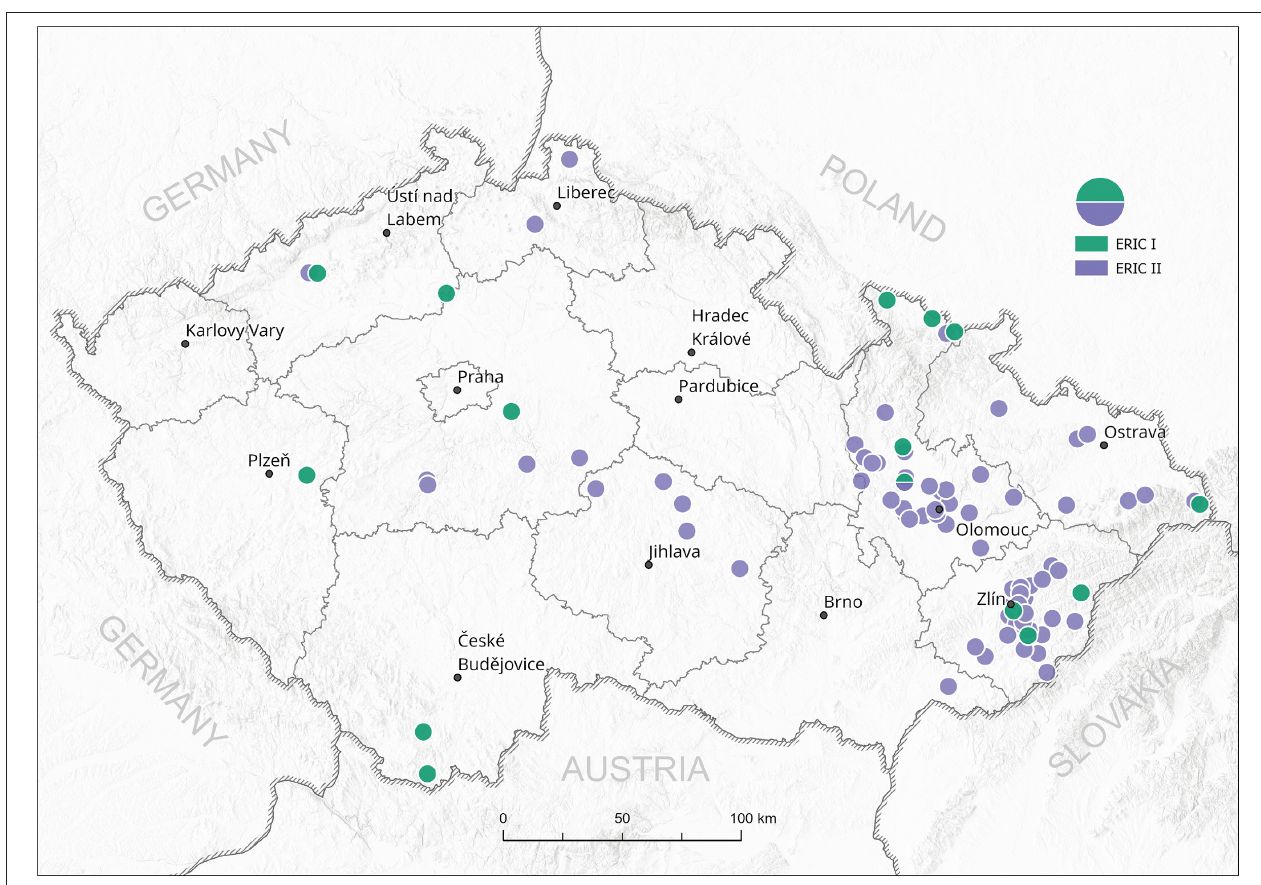
FIGURE 2 | Spread of P. larvae genotypes ERIC I and II in the Czech Republic. Green circles—ERIC I, violet circles—ERIC II; circles represent one or more field